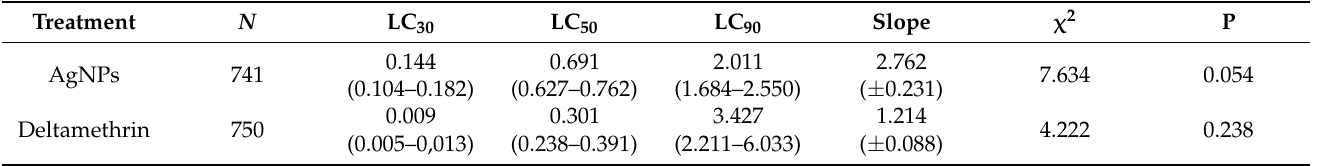
Table 3. Estimation of lethal concentration (LC) of silver nanoparticles synthesized with the